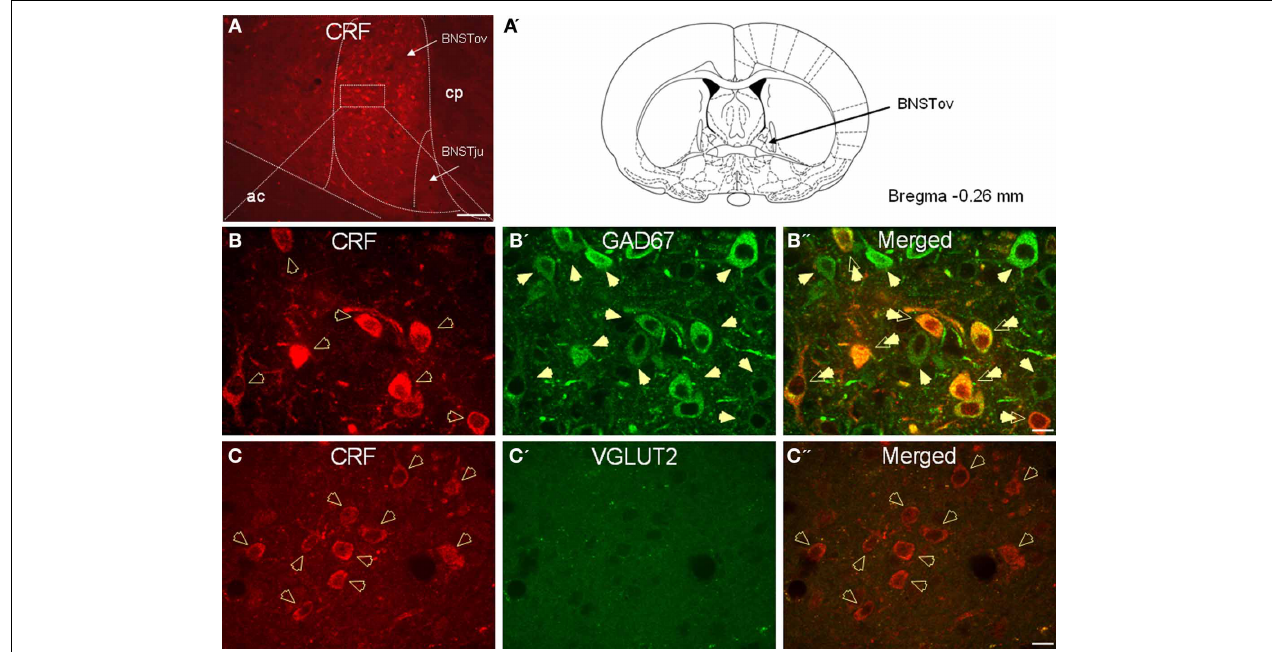
FIGURE 2 | (A) Photomicrograph showing high somatodendritic immunoreactivity of CRF in the BNST ALG (magnification 10 × , scale bar 100 μ , ac, anterior commissure; cp, caudate putamen; BNSTov, oval nucleus of the BNST; BNSTju, juxtacapsular nucleusof the BNST). (B–B”): Photomicrographs showing high-level co-localization of CRF ( B, red) and GAD67 ( B’, green) in the